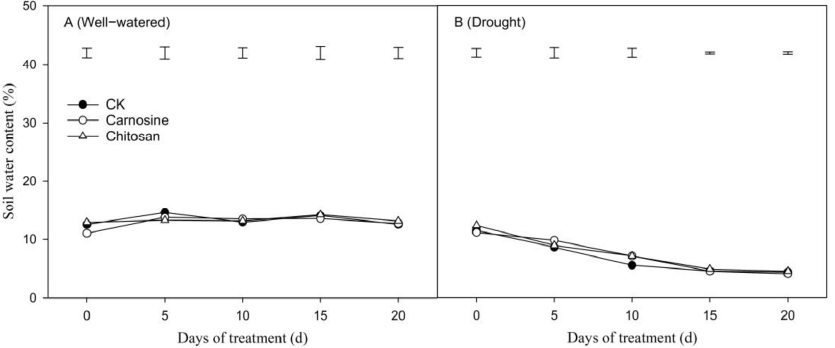
Figure 2. Effects of carnosine and chitosan on the soil water content in bermudagrass. ‘CK’ represents control plants sprayed with distilled water under both well-watered and drought stress. Vertical bars represent LSD values where a significant difference ( p < 0.05) was detected among different treatments at the same time point.